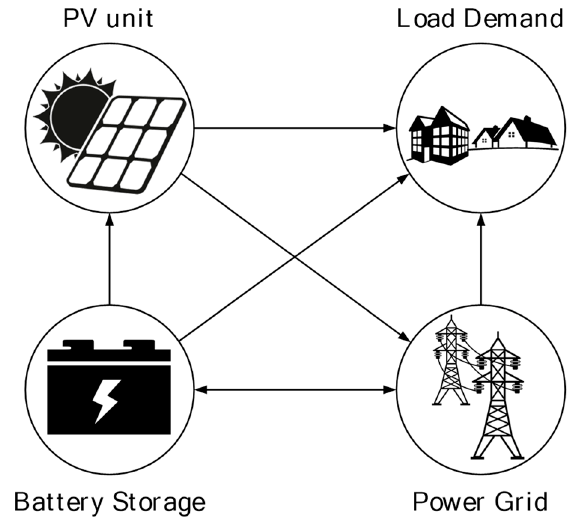
Figure 1. Proposed system overview of a microgrid.